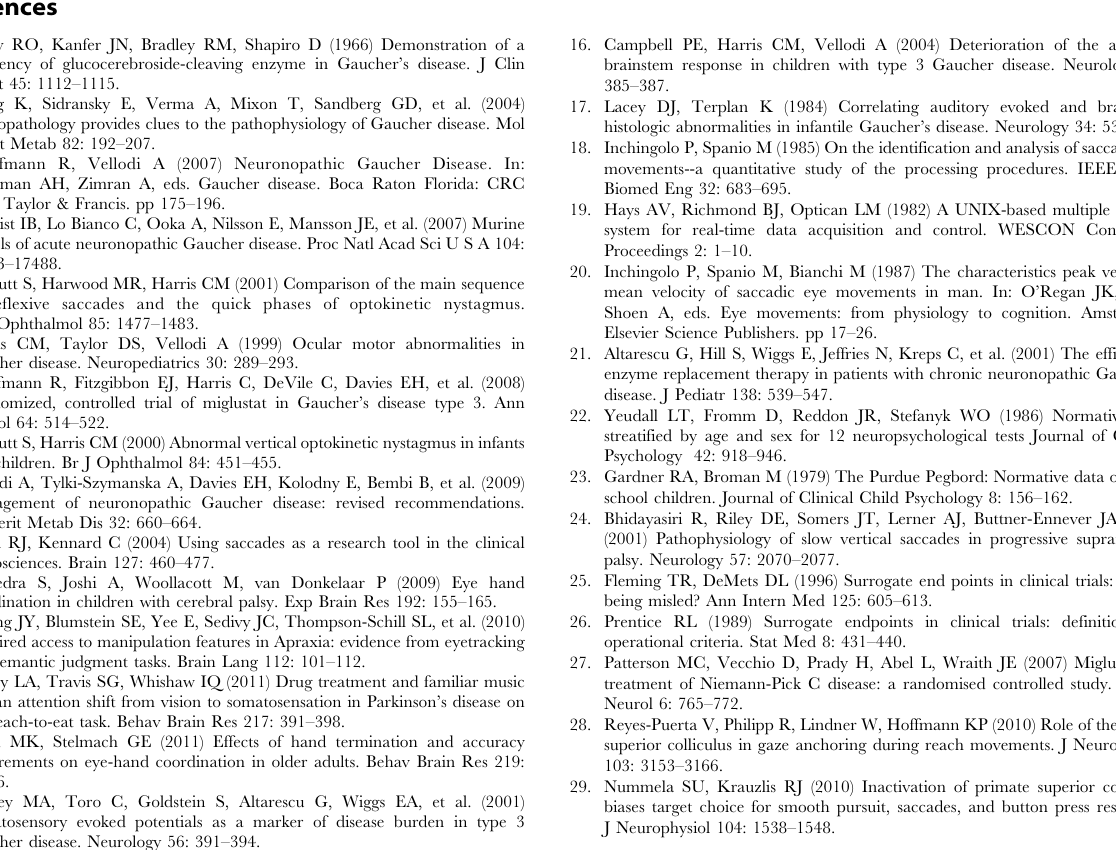
Protocol S1 Protocol Title: Clinical and Biochemical Effects of Macrophage-Targeted Glucocerebrosidase on Neurological